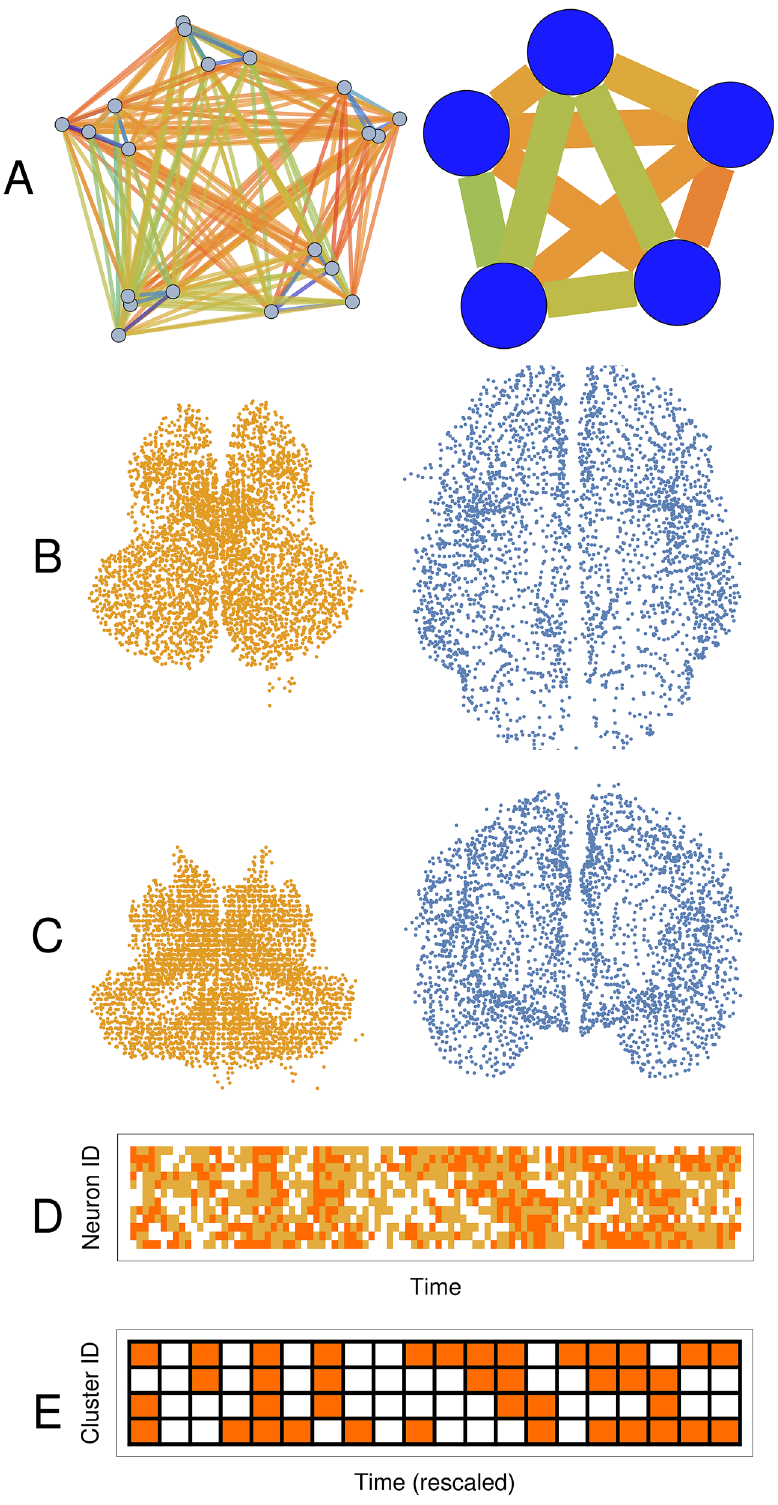
Figure 1. Re-scaling procedure for neuronal clusters and spike clusters demonstrates how proximate regions cluster together, reproducing organ-scale brain morphology. (A) We depict a fine-grain network of neurons (left) and its coarser, re-scaled version (right). Each ensemble-node, at a coarser level, is a collection of nodes from finer resolution level, clustered based on their connection weights (thin lines, left panel) with all edges between a pair of clusters averaged (thick lines, right panel). (B) Axial view of coarse-grained brain, after the procedure, at a cutoff of 0.98, re-scaling the original network of 91,282 nodes down to 7784 clusters. Each ensemble-node is located at the mean of coordinates of nodes comprising it. (C) Similarly, a coronal view. (D) The spike-train of fine-grain network is re-scaled into (E) ensemble-spike-train of coarser